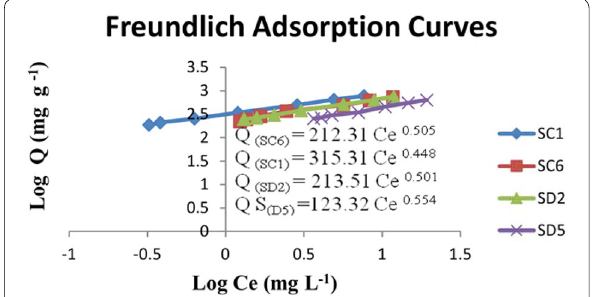
Fig. 5 Freundlich adsorption curves and equations for SC1, SC6, SD2 and SD5